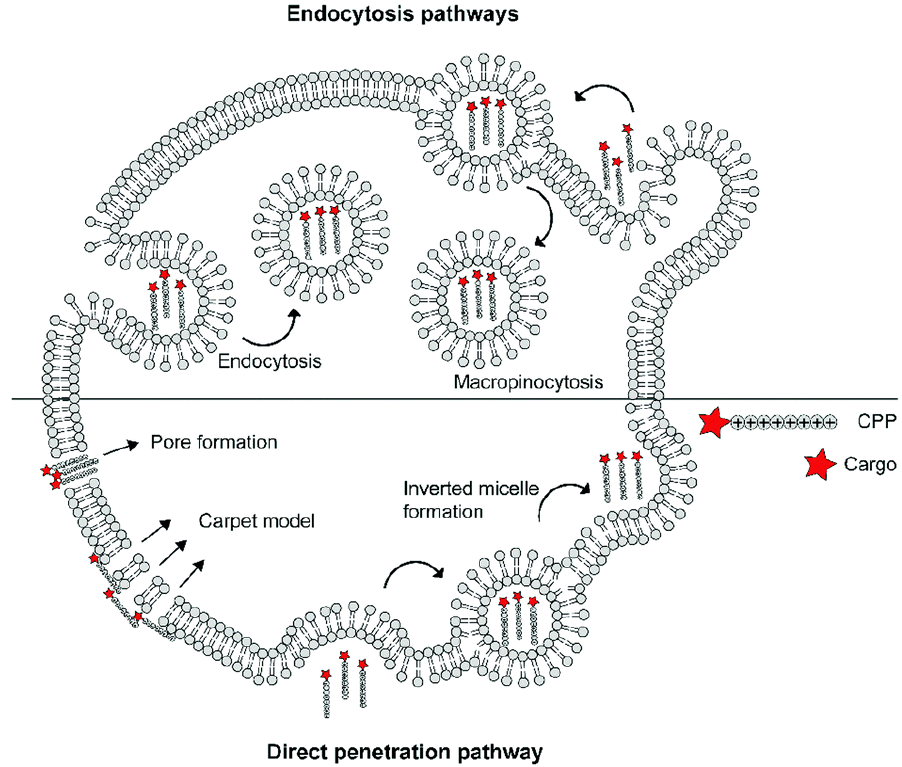
Figure 3. Schematic summary of different mechanisms underlying the cellular uptake of cell- penetrating peptide (reproduced with permission from de Jong et al., RSC Chemical Biology; pub- lished by RSC Publishing, 2020)